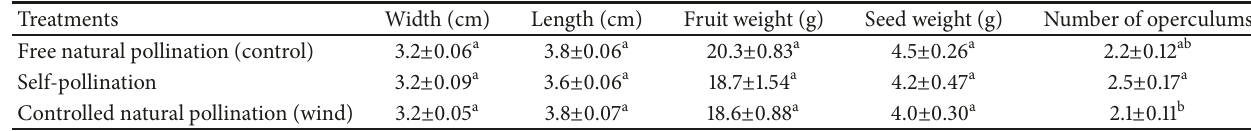
Table 2: Fruit parameters from control and self- and wind-pollinated treatments ( ± standard error).